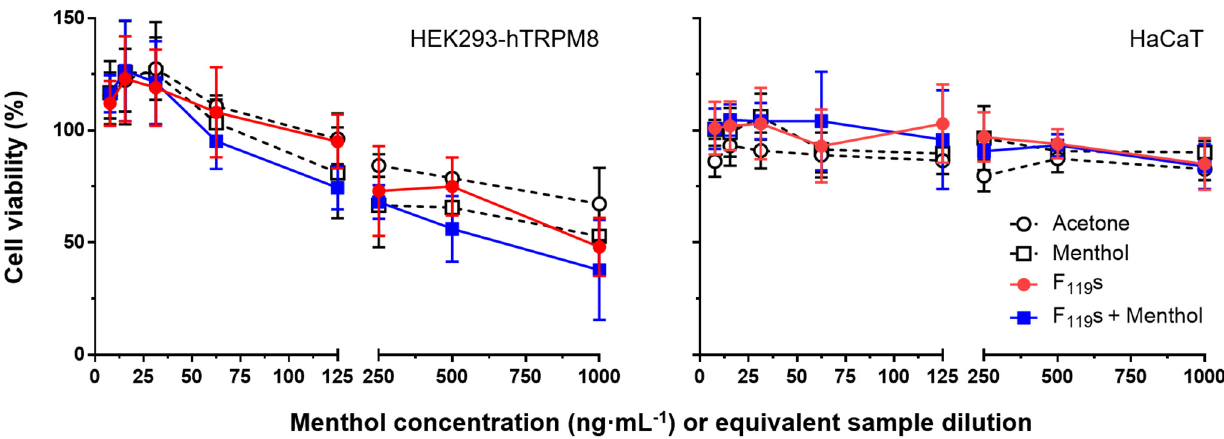
Figure 4. Viability of HEK293-hTRPM8 and HaCaT cells treated with F 119 s experimental samples. Treatments include a gradient of menthol concentrations and equivalent dilutions of F 119 s, menthol-loaded F 119 s, and acetone. Cell viability is calculated in percentage relative to non-treated control cells from the optical densities (570–620 nm) obtained at 24 h post treatment by the Thiazolyl Blue Tetrazolium Bromide (MTT) method. Results are shown as the mean with standard deviation from three independent experiments performed in quadruplicate. Statistical analysis comprised two-way ANOVA corrected with Tukey’s test for multiple comparisons, but no significant differences were found between the treatment groups at each concentration.